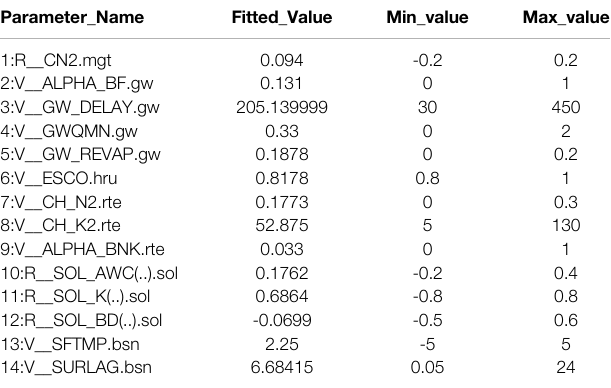
TABLE 3 | The best- fi tting parameters calculated using NS.